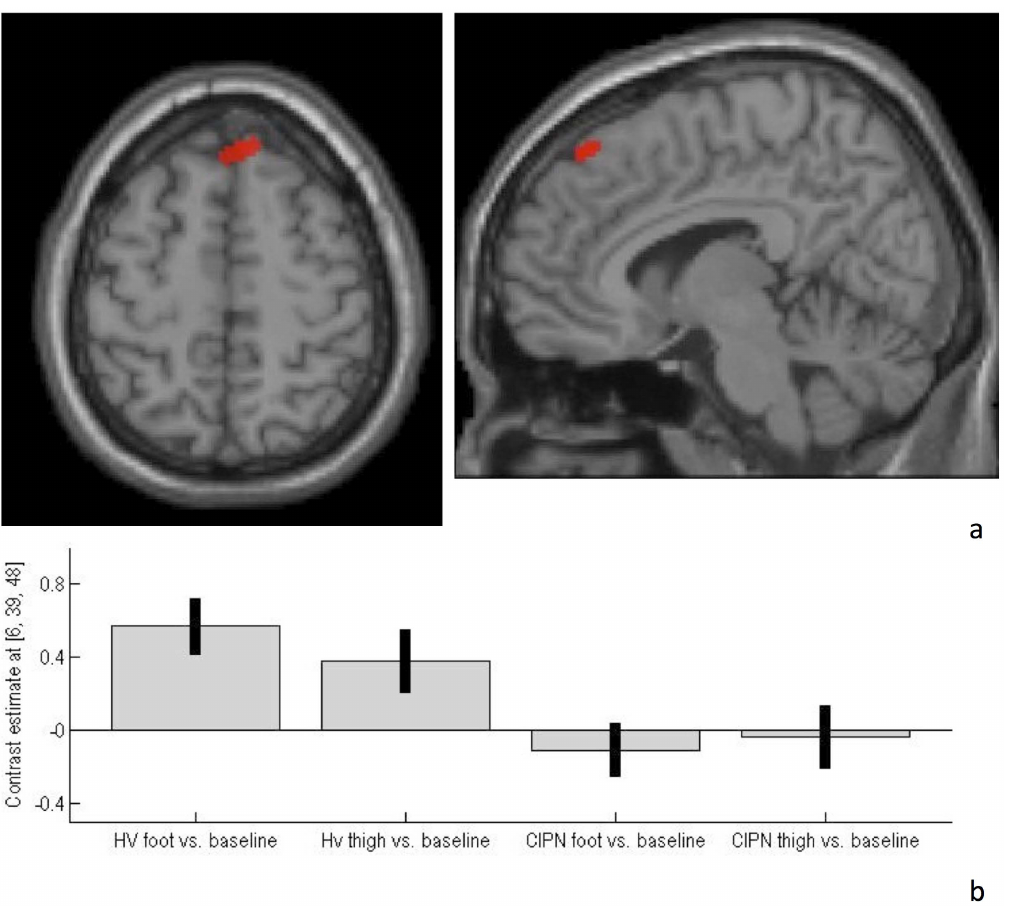
Figure 1. CIPN-myeloma patients demonstrated a) hypo-activation of superior frontal gyrus during heat-pain stimulation, compared with healthy volunteers. Functional imaging data are shown overlaid on both axial (z=48 mm) and sagittal (x=6 mm) slices through a canonical single-subject T1-weighted image. For display purposes, the statistical threshold is p , 0.001, uncorrected, at the voxel-level. b) Contrast estimates and 90% CI at co-ordinate 6, 39, 48 for both healthy volunteer and CIPN-myeloma patient groups.